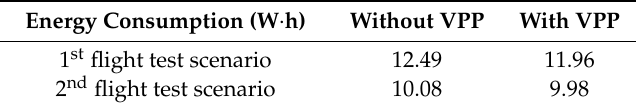
Table 3. Total energy consumption with and without a VPP controller.